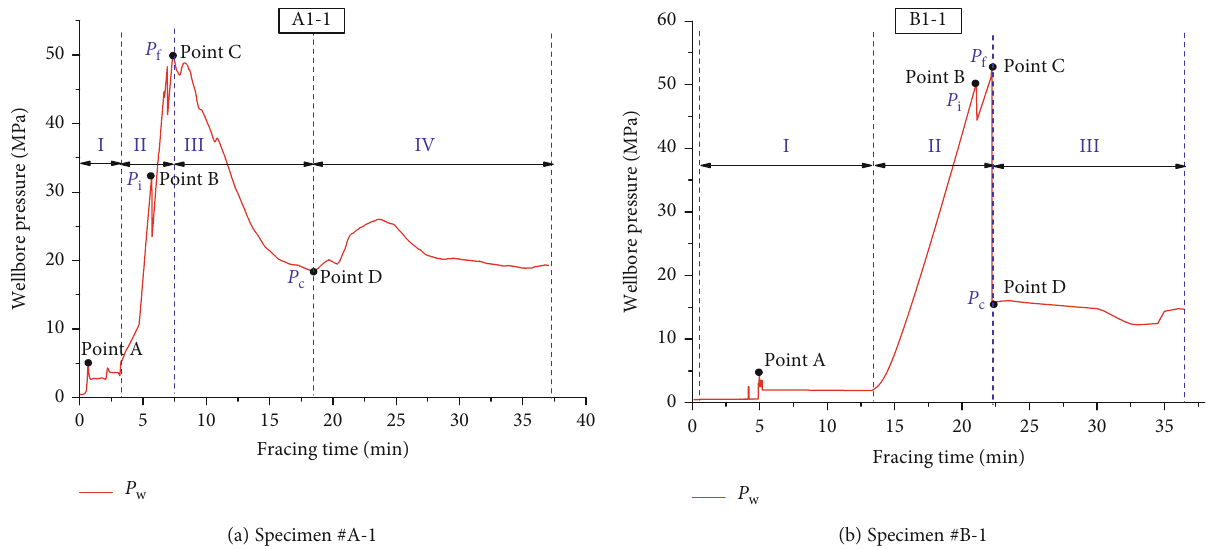
Figure 8: Fluid pressure in wellbore versus fracing time for specimens #A-1 and #B-1.